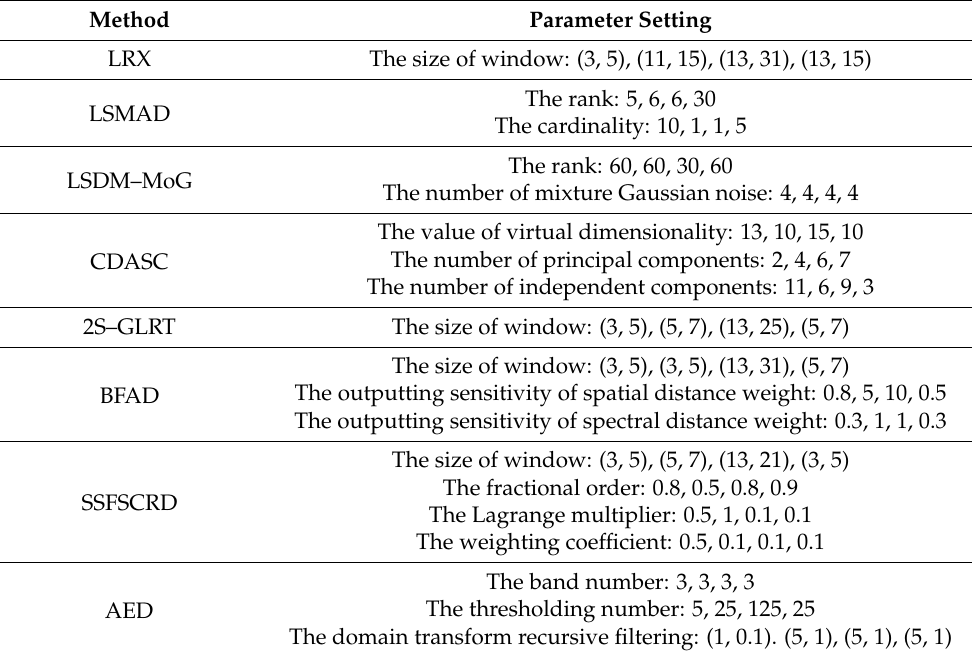
Table 1. Uncertain parameter settings for different alternative methods on four